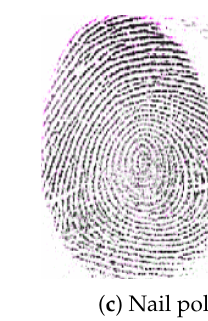
Figure 3. The impact of pressure on the pattern shape. Each sub-image demonstrates two frames taken from a video and matched. Colors are: initial frame in green, later frame in magenta, and the matching pattern in black. ( a ) Bona